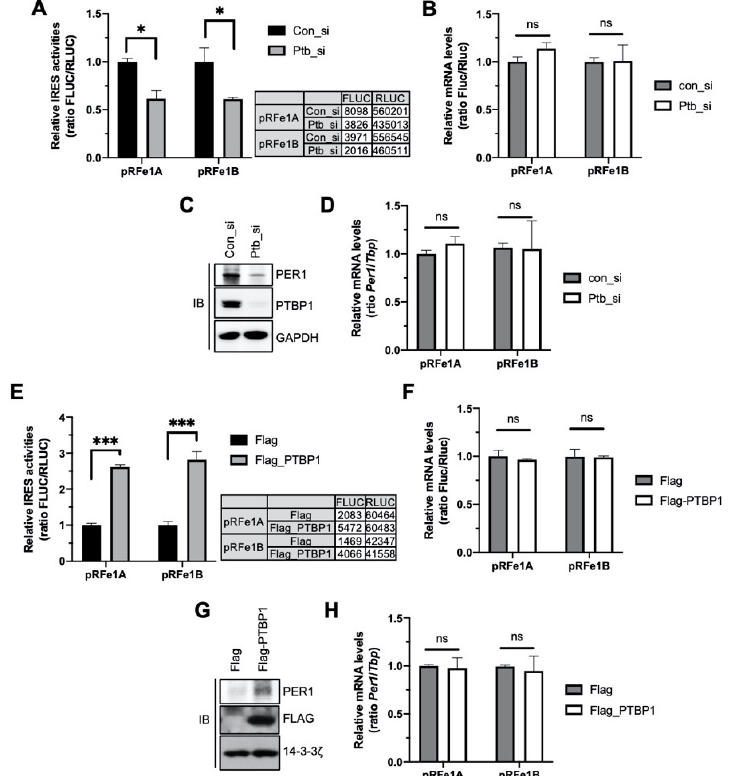
Figure 2. Polypyrimidine tract-binding protein 1 (PTBP1) controls the internal ribosomal entry site (IRES) activity of Per1 and the PER1 protein levels. ( A ) Bicistronic plasmids, pRFe1A and pRFe1B, containing the Per1 5 ′ -untranslated regions (UTRs) were transfected into cells with control or Ptbp1-specific siRNAs. These cells were used for measuring the luciferase activities; the relative IRES activities are shown. n = 3; * p < 0.05, as determined by two-way ANOVA with Sidak’s multiple comparison test. ( B ) From the cells mentioned for panel A, total RNA was prepared and real-time polymerase chain reaction (PCR) was performed with Fluc- and Rluc -specific primers. n = 3; two-way ANOVA with Sidak’s multiple comparison test was performed. Two variables are ‘type of Per1 5 ′ UTRs’ and ‘con_si or Ptb_si’. ( C ) The knockdown of Ptbp1 shown in panel A was confirmed by immunoblotting with the indicated antibodies. Endogenous PER1 protein levels were also assessed. The blots were cropped from the different parts of the same gel. ( D ) Relative endogenous Per1 mRNA levels in the samples used for panel B were measured by real-time PCR. n = 3; two-way ANOVA with Sidak’s multiple comparison test was performed. ( E ) Bicistronic plasmids harboring the Per1 5 ′ -UTRs were transfected with Flag or Flag-PTBP1 into HEK 293 cells. After 24 h of incubation, the cells were subjected to luciferase assay. n = 3; *** p < 0.001, as determined by two-way ANOVA with Sidak’s multiple comparison test. ( F ) Total RNA was prepared from the cells mentioned for panel E and used for real-time PCR with Fluc- and Rluc - specific primers. n = 3; two-way ANOVA with Sidak’s multiple comparison test was performed. ( G ) Overexpression of PTBP1 shown in panel E and endogenous PER1 protein levels were checked by immunoblotting by using the same extract as mentioned for panel E. Endogenous Per1 mRNA levels were quantitated using the same samples as mentioned for panel F. The blots were cropped from the different parts of the same gel and incubated with different antibodies and for different times. (H) Relative endogenous Per1 mRNA levels were measured after PTBP1 overexpression. n = 3; two-way ANOVA with Sidak’s multiple comparison test was performed.